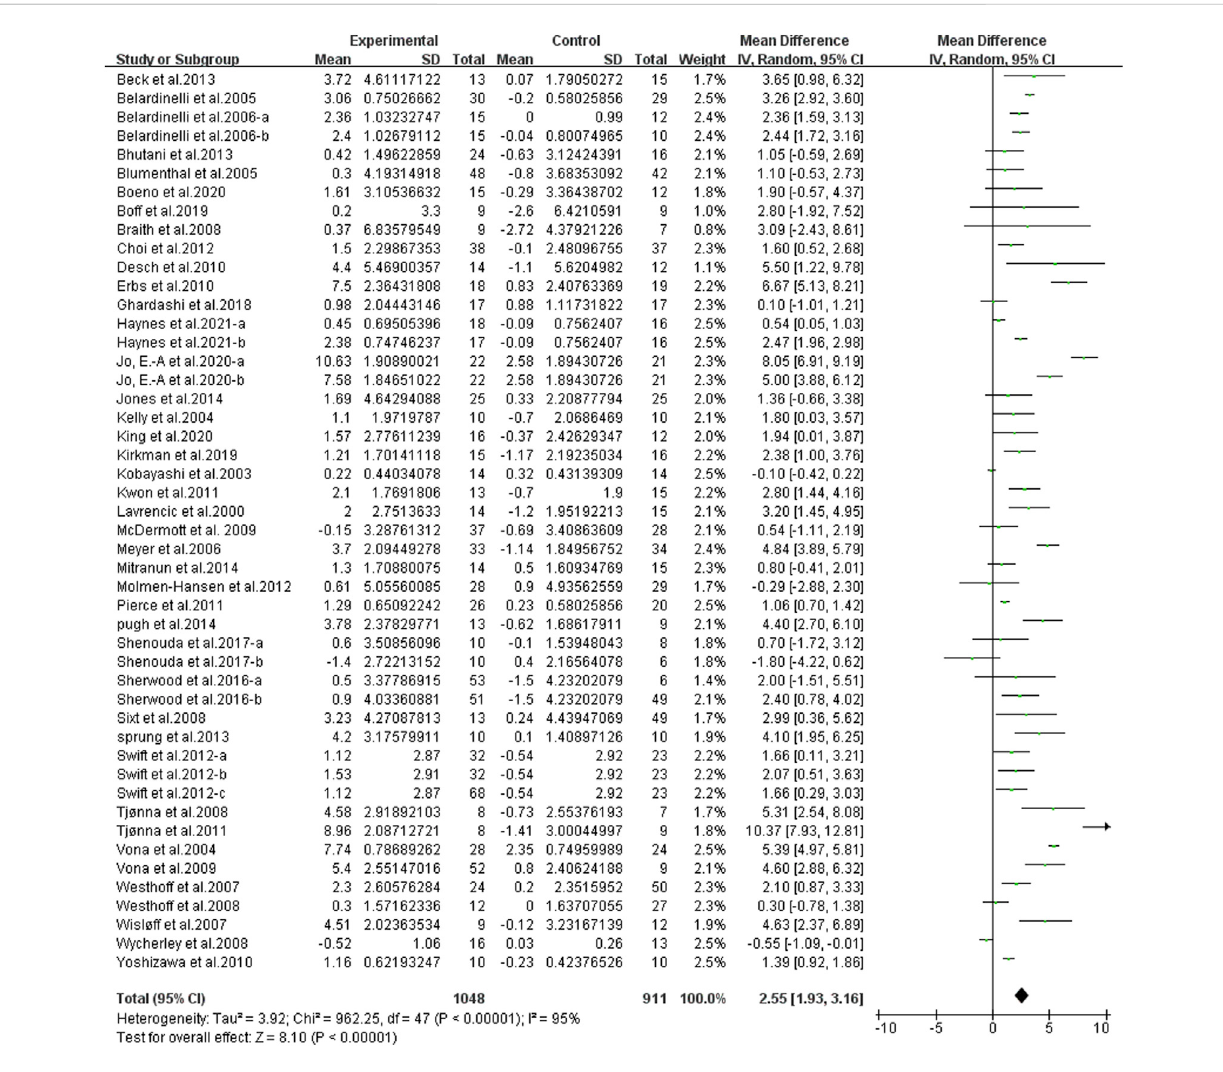
FIGURE 5 Meta-analysis results of the effect of continuous aerobic exercise on FMD. The pooled estimates were obtained from random effects analysis. DiamondsindicatedtheeffectsizeofeachstudysummarizedasWMD.Thesizeoftheshadedsquareswasproportionaltothepercentageweightofeach study. Horizontal lines represented the 95% CI and the vertical line represented the overall